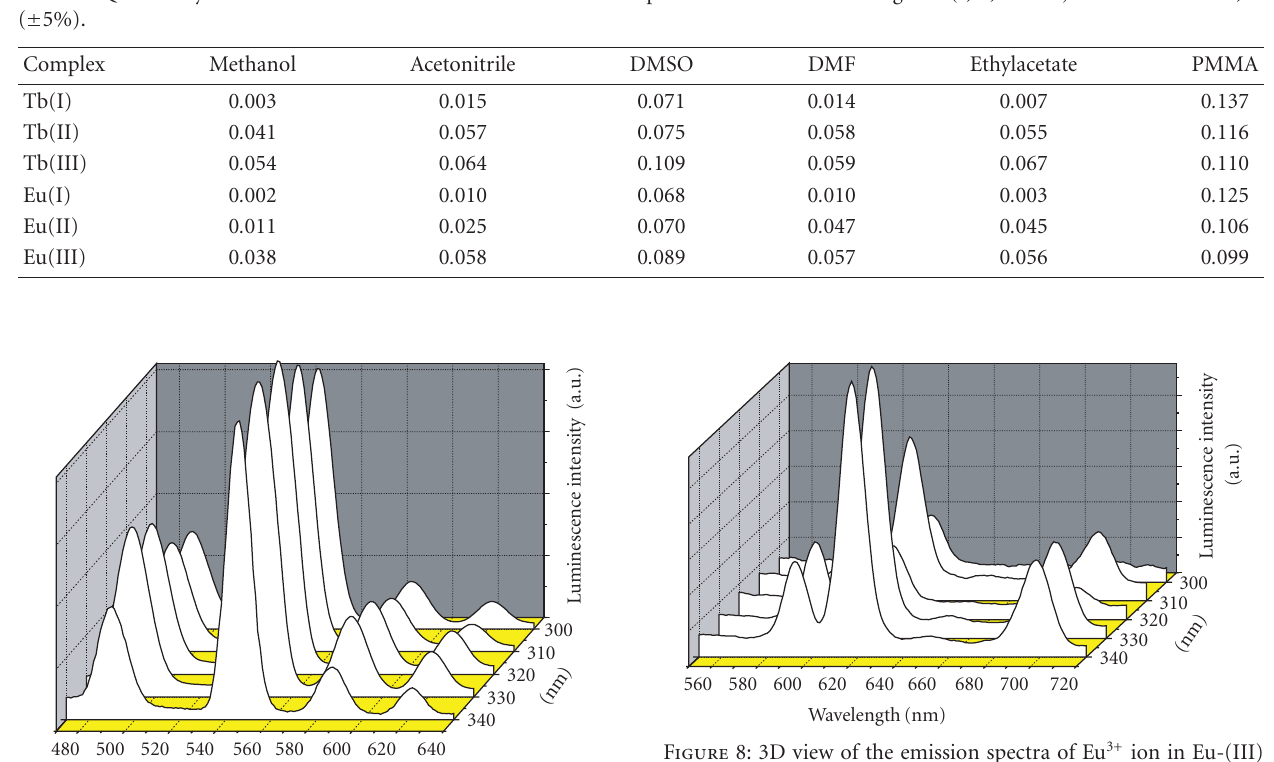
10 (cid:0) 5 M of ligands (I,II, and III) in di ff erent media, Φ (cid:0)